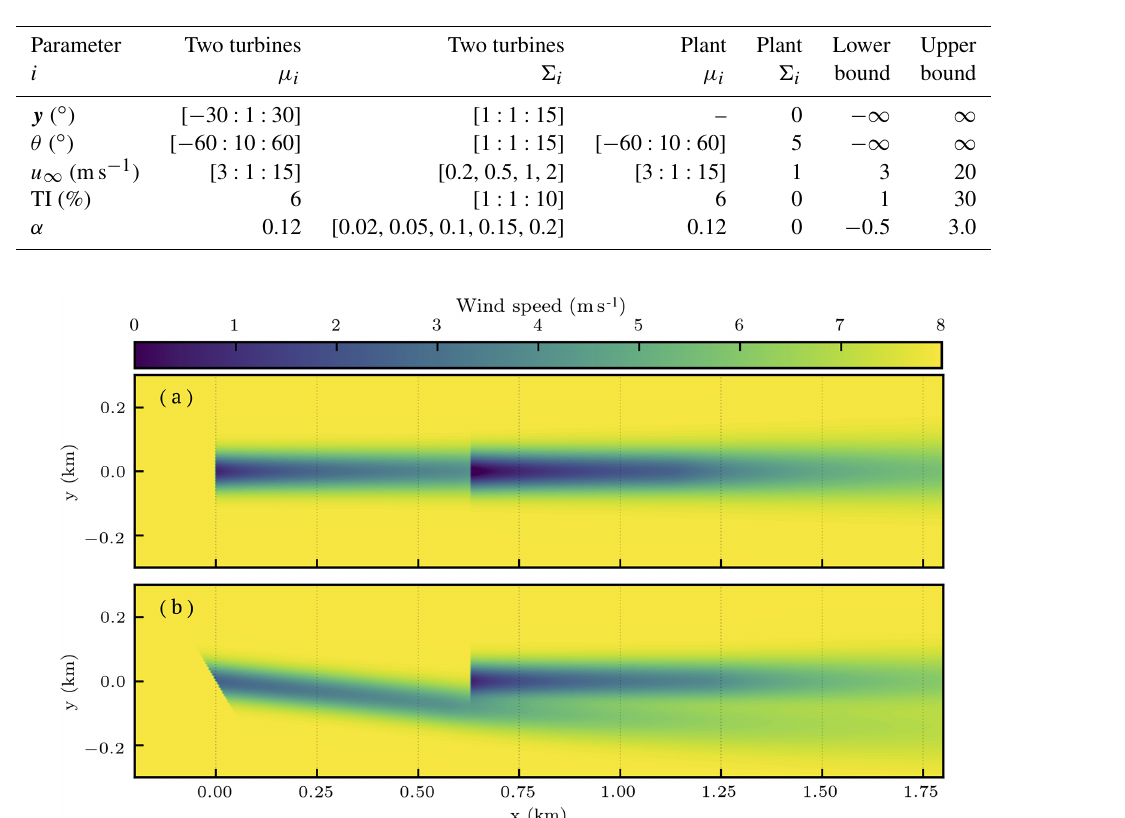
Table 3. Mean and scale values and lower and upper bounds used in the two-turbine and wind plant OUU problems. Sequences are expressed as [start : increment : end].